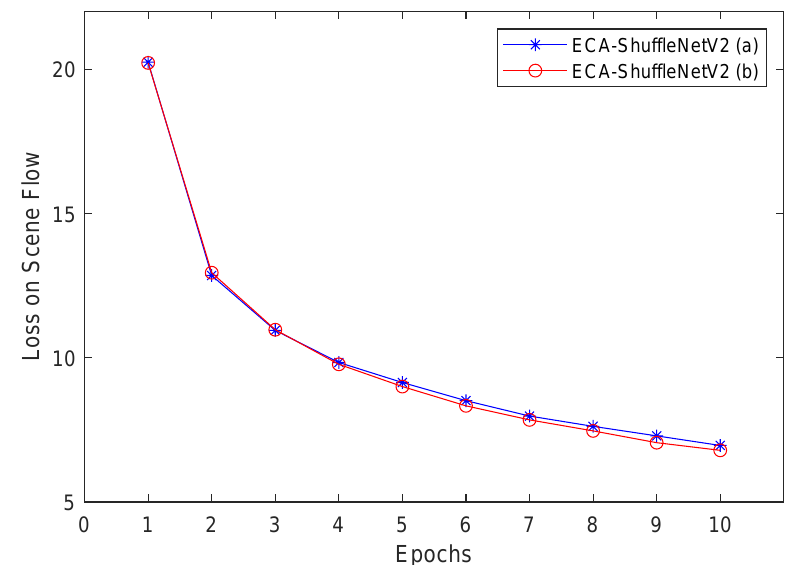
Figure A2. Training loss on Scene Flow data set with 3D ECA-ShuffeNetV2 ( a ) & ( b